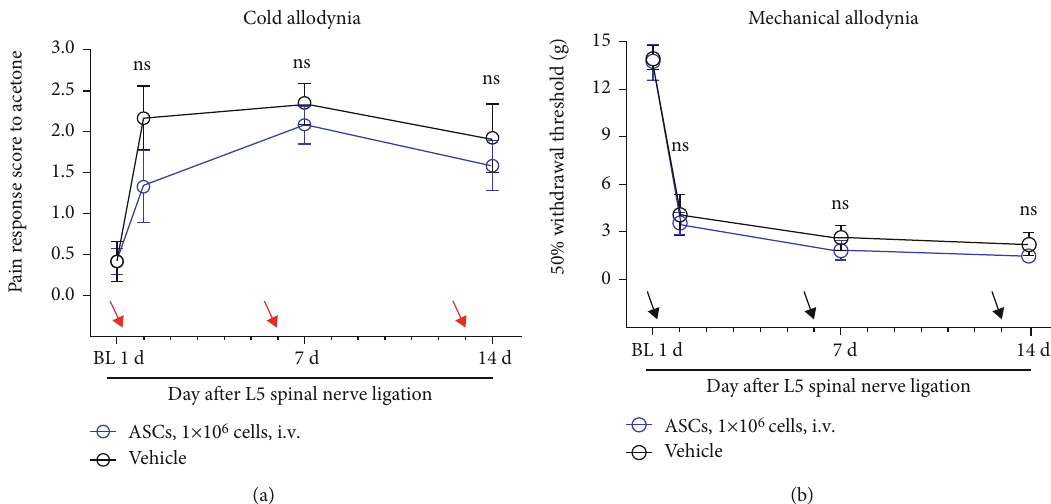
Figure 2: Absence of analgesic e ff ect following the retro -orbital injection of ASCs on the rat model with L5 spinal nerve ligation. (a, b) No e ff ect observed on cold allodynia (a) and mechanical allodynia (b) by treatment with ASCs ( 1 × 10 6 cells) after the L5 spinal nerve ligation surgery. Arrows indicate time of injection (POD 0, POD 6, POD 13). p > 0 : 05 , compared with vehicle (20 μ l DMEM); p > 0 : 05 , compared with n = 6 rats/group. All data are expressed as the mean ± SEM . Statistical signi fi cance was determined by 2-way ANOVA, followed by Sidak ’ s posthoc test. ns: not signi fi cant; POD: postoperative day; BL: baseline; i.v. : intravenous injection; ASC: adipose tissue-derived stem cell; DMEM: Dulbecco ’ s modi fi ed Eagle ’ s high-glucose medium.